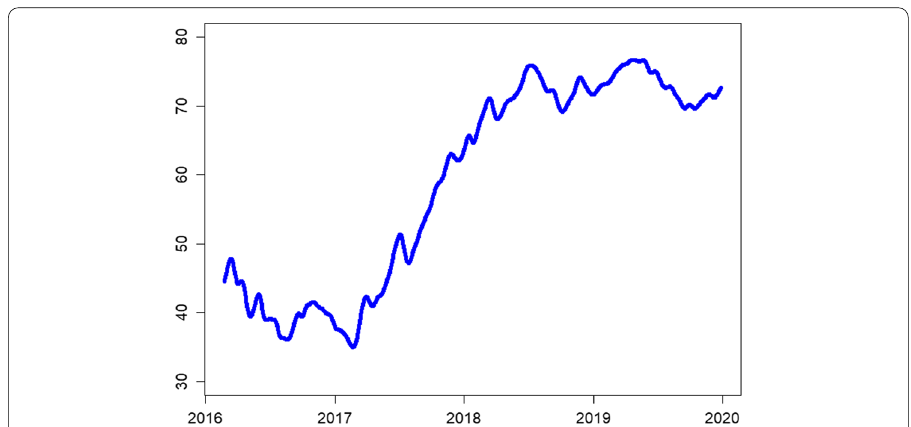
Fig. 9 Rolling-window based total return spillover index based on the DY approach. Note : 200 days rolling window, lag order 12 based on AIC